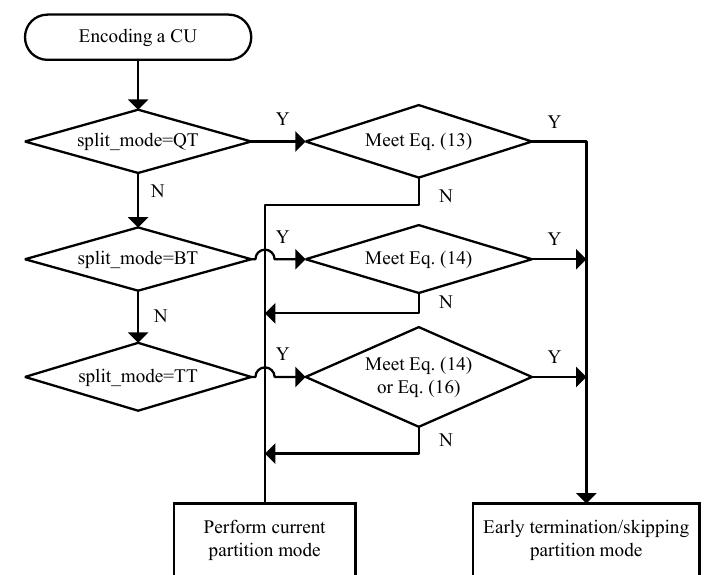
Figure 4. The flowchart of the proposed